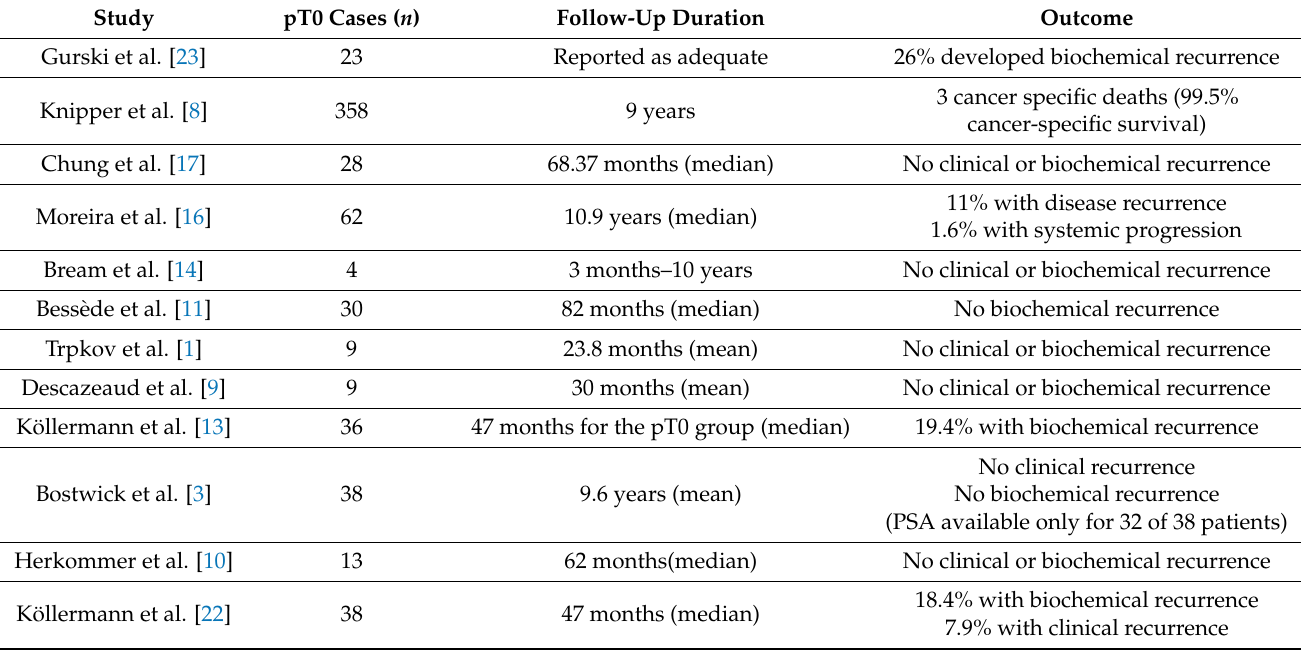
Table 1. Oncological outcomes of patients with pT0